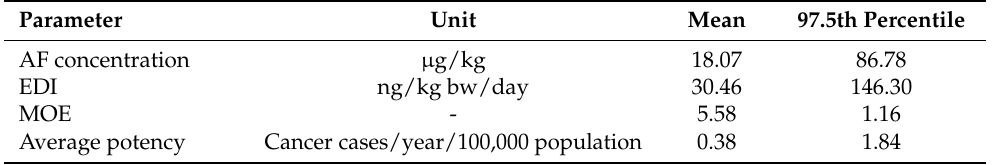
Table 4. Dietary exposure of aflatoxin and assessment of risk due to consumption of maize in